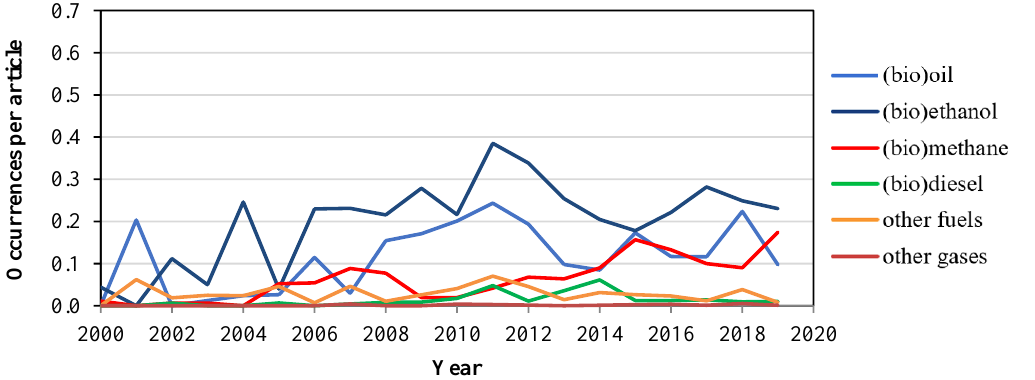
Figure 10. Trend chart of terms related to produced biogases and biofuels.